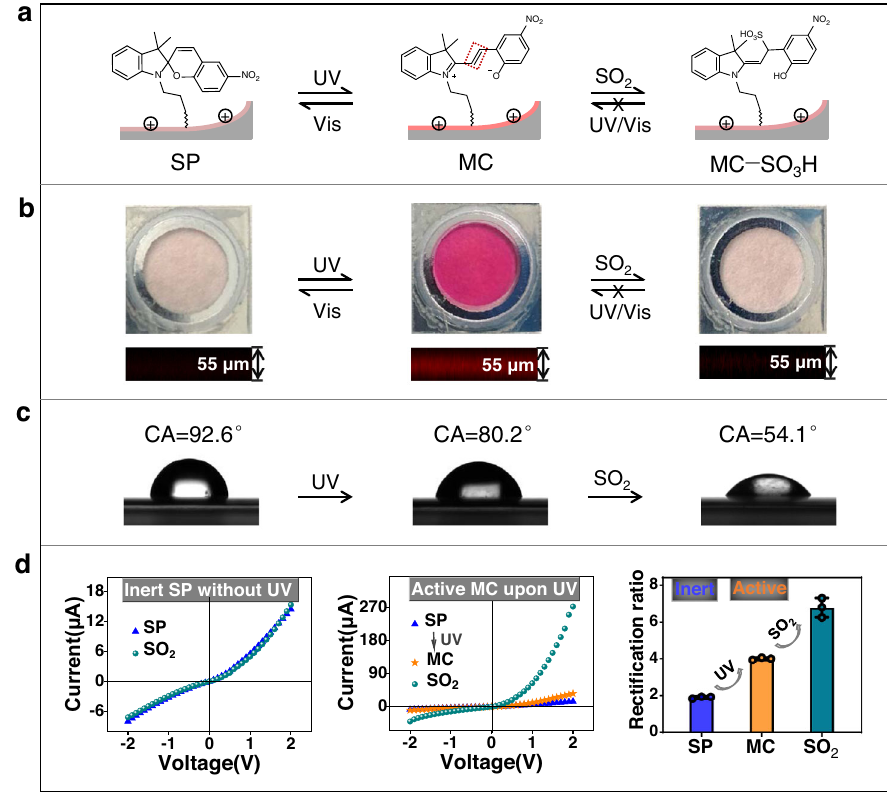
Fig. 3 | Light-controlled inert/active state-switchable sensor for SO 2 and the photochromicpropertiesoftheSP/AAOnanochannels.a Schematicdiagramof thelight-controlledSP/AAOnanochannelsensorforSO 2 .Thereddashedboxisthe C=C response site in MC form. b Change in optical colour and confocal fl uores- cence and ( c ) CA measurements of SP/AAO nanochannels during the light- controlleddetectionofSO 2 . d I – VcurvesofSP/AAOnanochannelstreatedwithSO 2